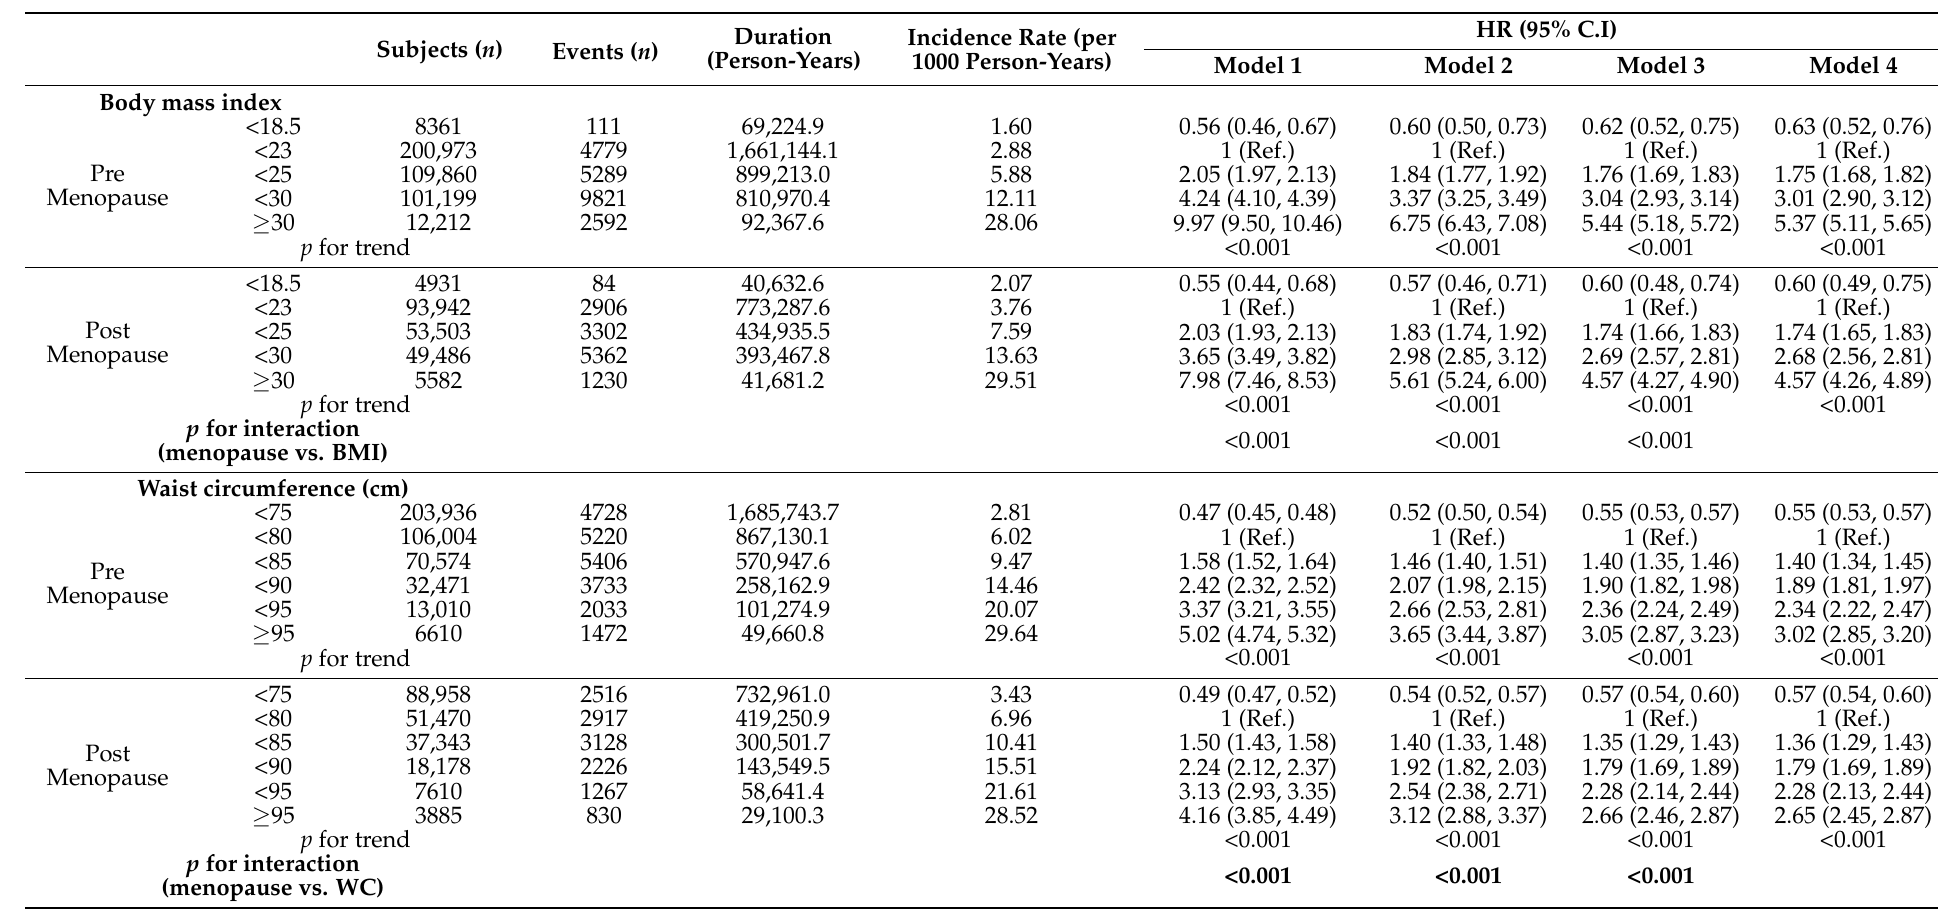
Table 4. Associations between body mass index, waist circumference, and type 2 diabetes risk by menopausal status in 45–54-year-old women.